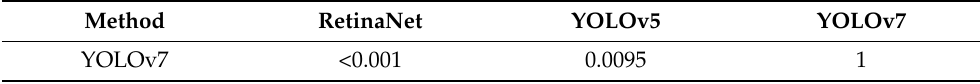
Table 3. p -Values of the McNemar’s significance test on Le2i dataset. Here, p < 0.05 is statistically